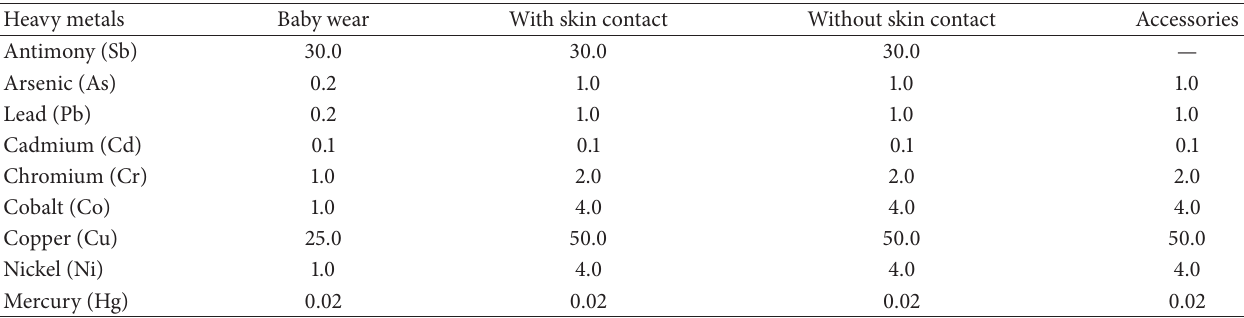
Table 1: Oeko-Tex Standard 100 limit values (mgkg −1 ).